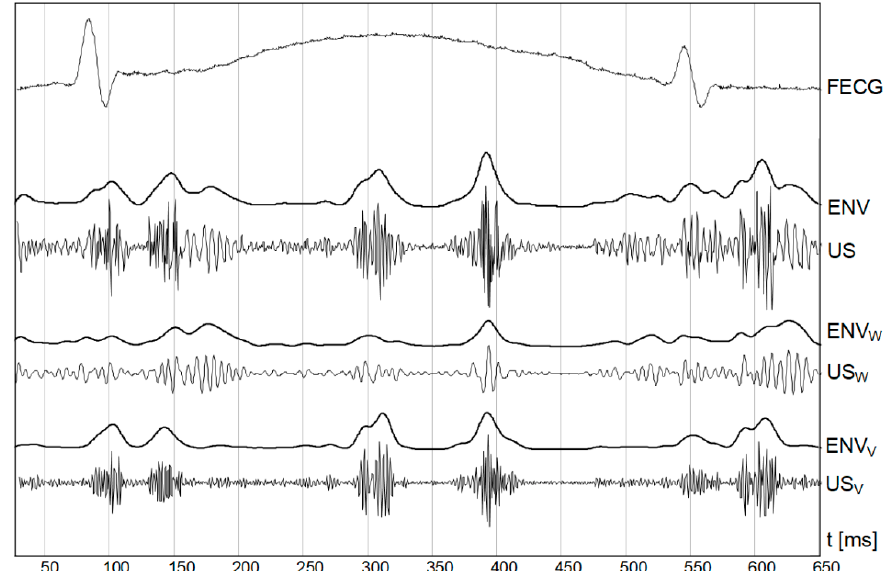
Figure 2. Doppler ultrasound signal (US) with separated components relating to the fetal heart wall (US W ) and valve (US V ) movements. Corresponding envelopes (ENV W and ENV V ) are shown together with an envelope of full signal (ENV).